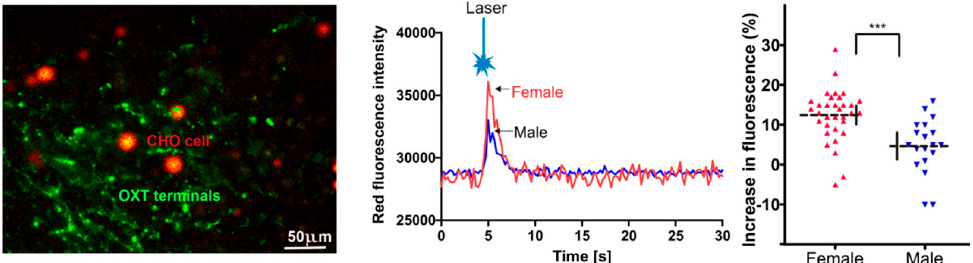
Figure 4. Sniffer CHO cells show that the release of OXT from PVN OXT fibers in the LC is greater in females than males. A representative confocal image showing sniffer CHO cells expressing OXT receptors and the Ca indicator R-GECO1 (red) in close apposition to PVN OXT ChR2-EYFP fibers (green). Scale bar 50 µm (left). A single laser pulse photo-activated ChR2 fibers and increased R- GECO1 fluorescence in neighboring sniffer CHO cells (middle). The responses were significantly greater in females than in males